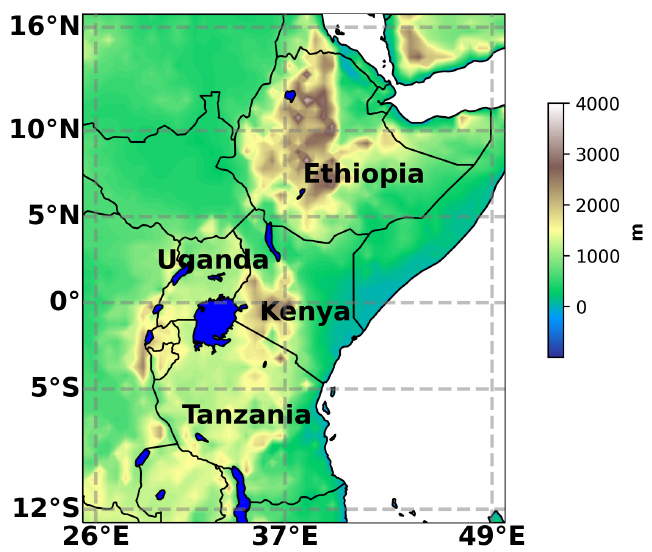
Figure 1. Topography in the study region of East Africa (25 ◦ E to 50 ◦ E and 13 ◦ S to 17 ◦